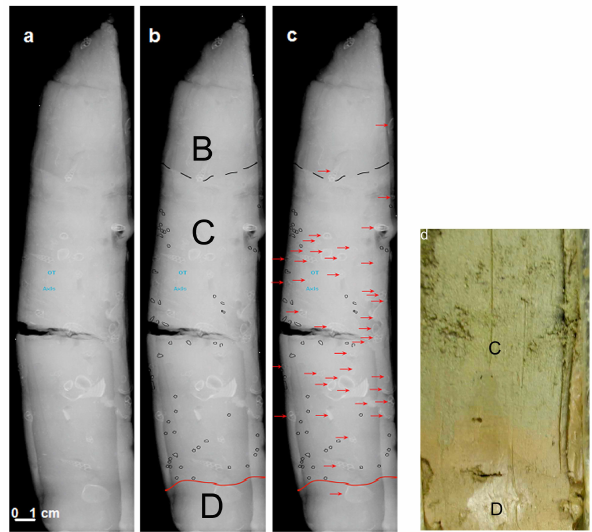
Fig. 6. (a) X-ray photography of unit C from core OB4. (b) -X-ray photography of unit C from core OB4 – the black circles indicates coarser clasts. (c) -X-ray photography of unit C from core OB4 – the arrows indicates fossil fragments. (d) Photography of contact between unit C and D in core OB4 (for core location please check Fig. 1e).